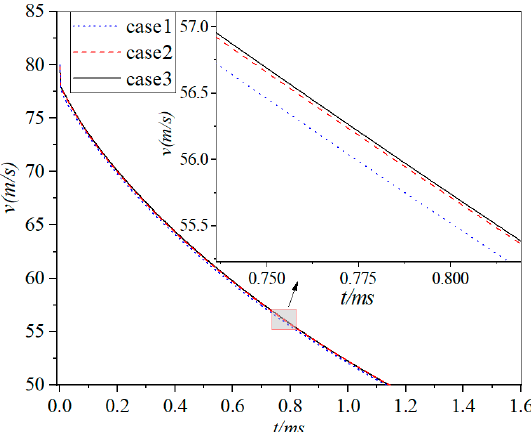
Figure 5. Comparison of velocity change in the projectile for three cases with different grid numbers.